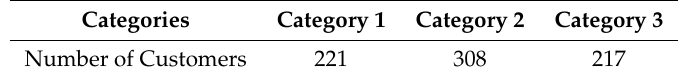
Table 4. Number of each clustering category.